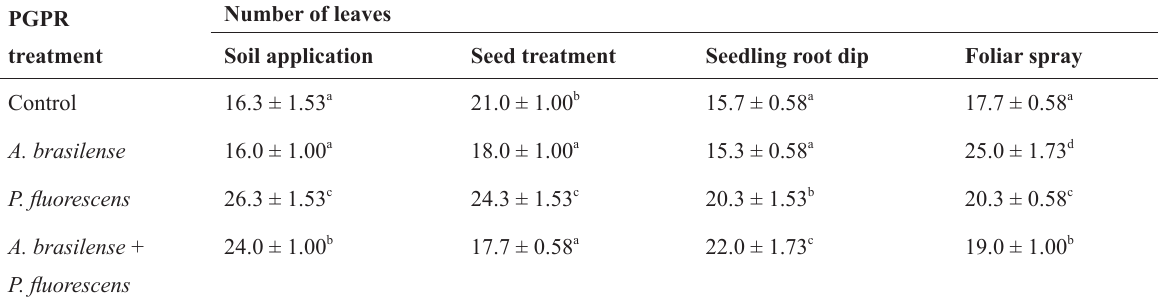
Effect of methods of application of single and mixed PGPR on the number of leaves in groundnut plants.